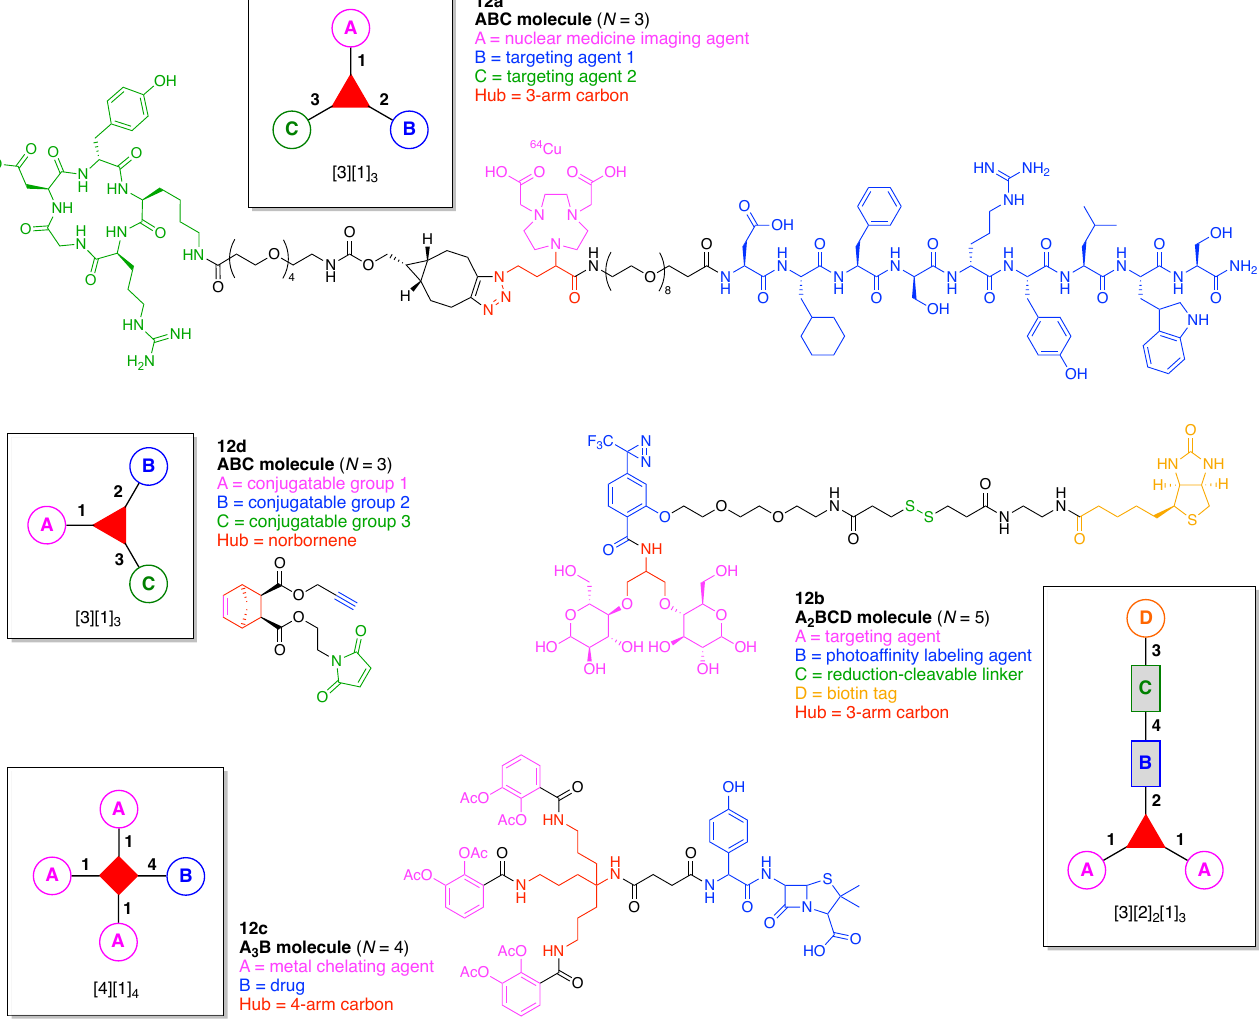
B = photoaffinity labeling agent C = reduction-cleavable linker D = biotin tag Hub = 3-arm carbon